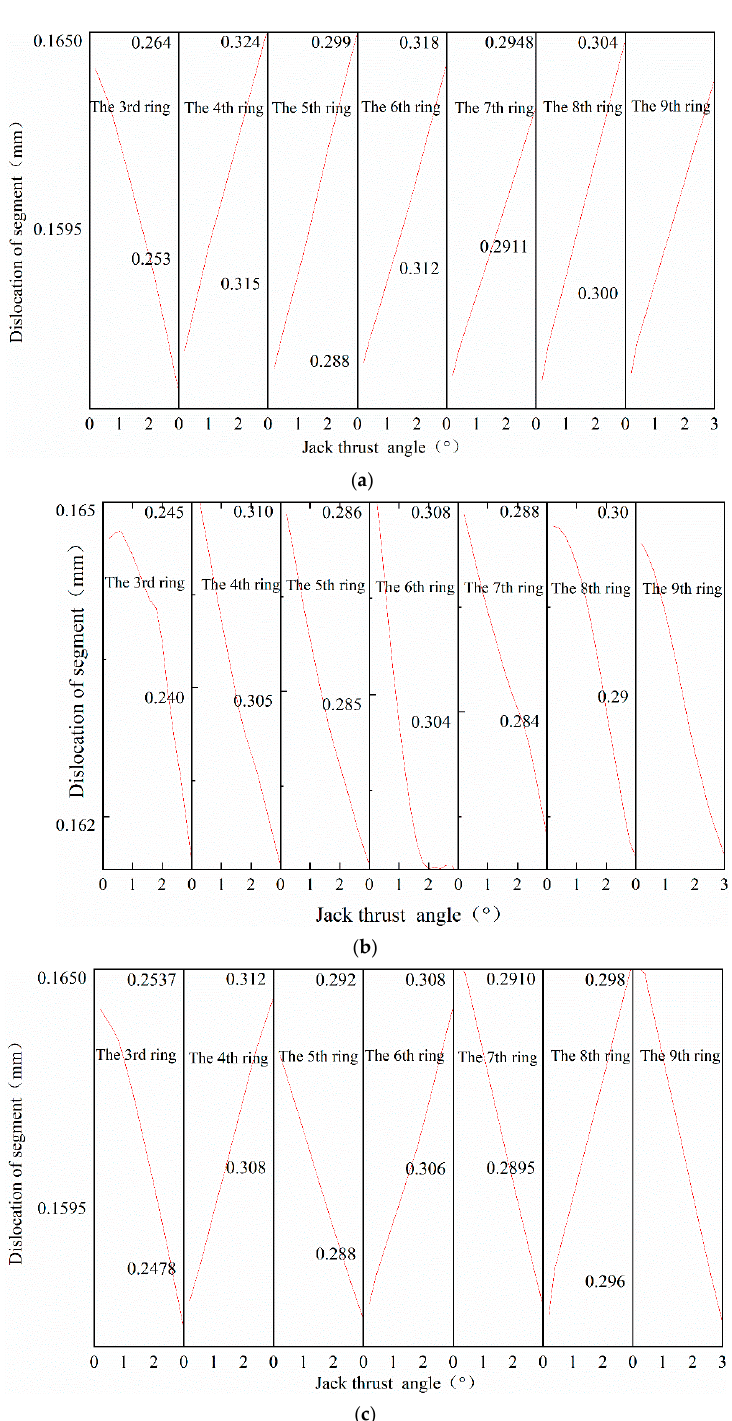
Figure 13. Maximum Dislocation. ( a ) Upward direction of shield machine. ( b ) Downward direction of shield machine. ( c ) Left direction of shield machine.